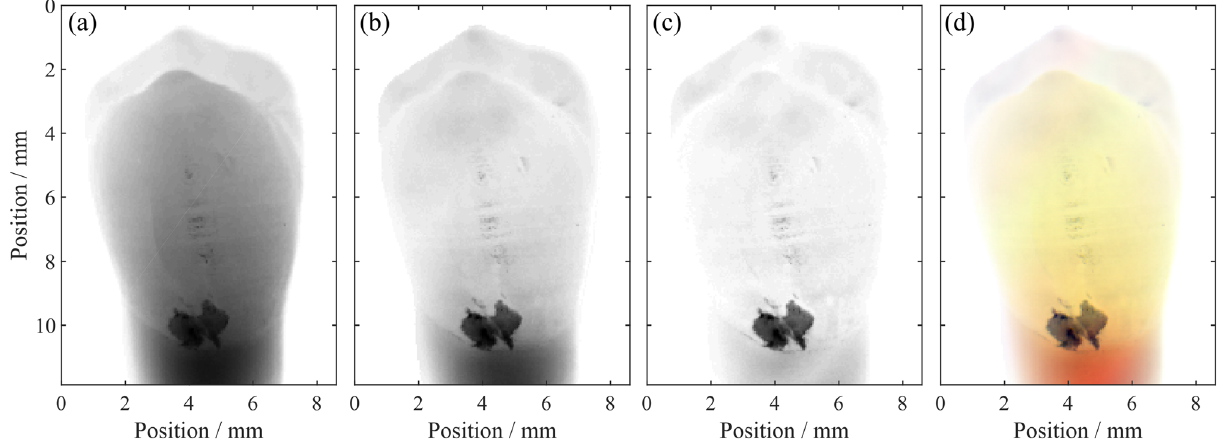
1 1 1 , ( b ) 0.2 mm − and ( c ) 0.5 mm − . ( d ) Combining these three data-sets